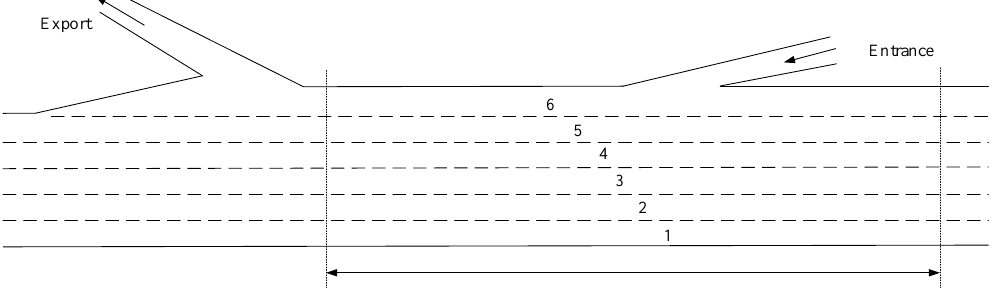
Figure 5. I-80 road structure.